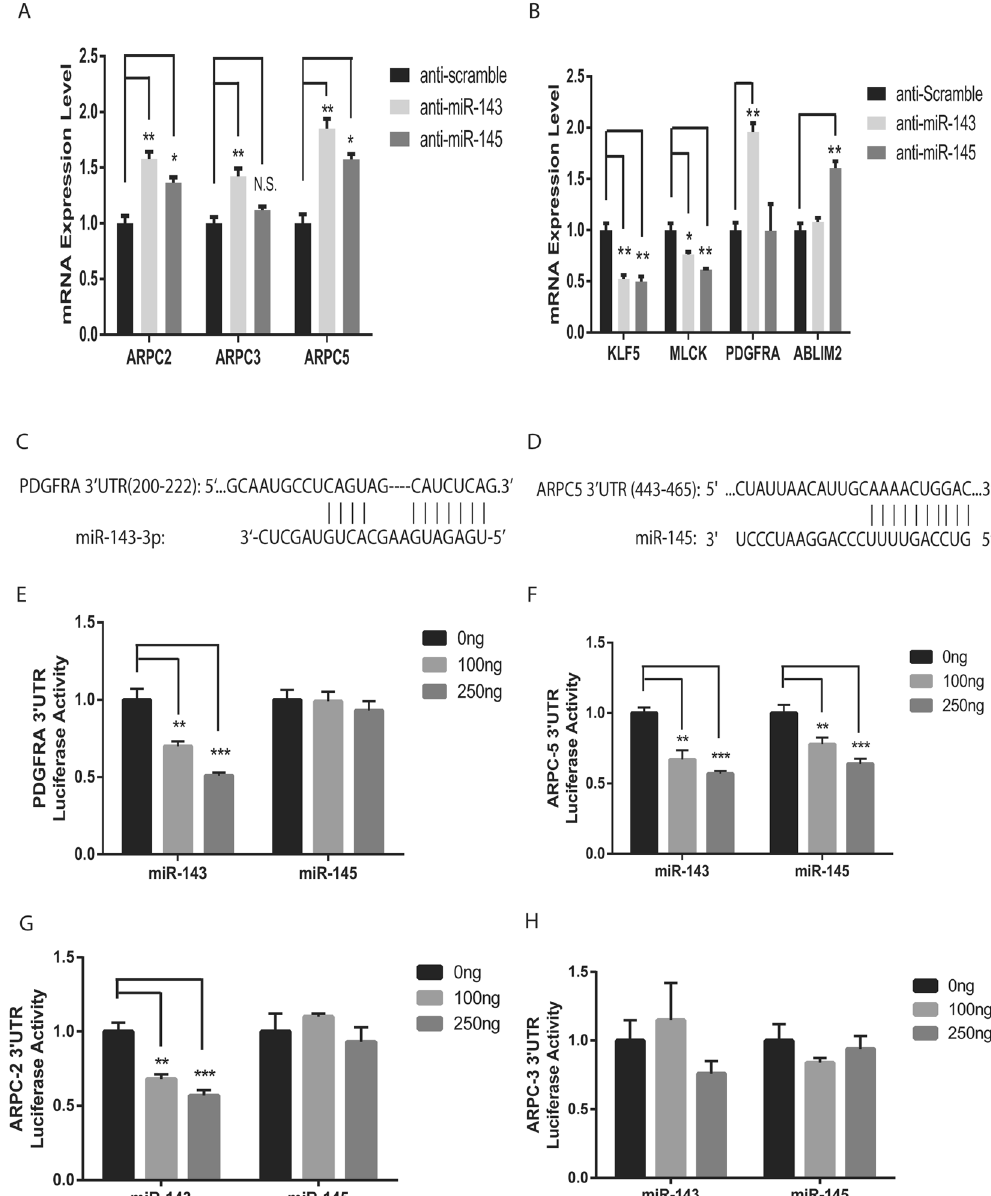
Figure 5. Regulation of miR-143/145 target genes and glaucoma-related genes by miR-143/145. ( A ) Upregulation of ARPC-2, -3 and -5 by miR-143 or miR-145 silencing. * p < 0.05, ** p < 0.01, N.S., not significant; ( B ) Downregulation of KLF5 and MLCK by miR-143 or miR-145 silencing. PDGFRA was upregulated by miR-143 silencing, and ABLIM2 was upregulated by miR-145 silencing. * p < 0.05, ** p < 0.01; ( C ) Sequence alignment of PDGFRA 3 ′ -UTR and miR-143-3p, with complementary nucleotides indicated by lines; ( D ) Sequence alignment of ARPC5 3 ′ UTR and miR-145-5p, with complementary nucleotides indicated by lines; ( E ) miR-143 but not miR-145 overexpression repressed PDGFRA 3 ′ -UTR activity in a dose-dependent manner. ** p < 0.01, *** p < 0.001; ( F ) Either miR-143 or miR-145 overexpression repressed ARPC5 3 ′ UTR activity in a dose-dependent manner. ** p < 0.01; *** p < 0.001. ( G ) miR-143 but not miR-145 overexpression repressed ARPC-2 3 ′ -UTR activity in a dose-dependent manner. ** p < 0.01, *** p < 0.001; ( H ) Neither miR- 143 nor miR-145 overexpression repressed ARPC-3 3 ′ -UTR